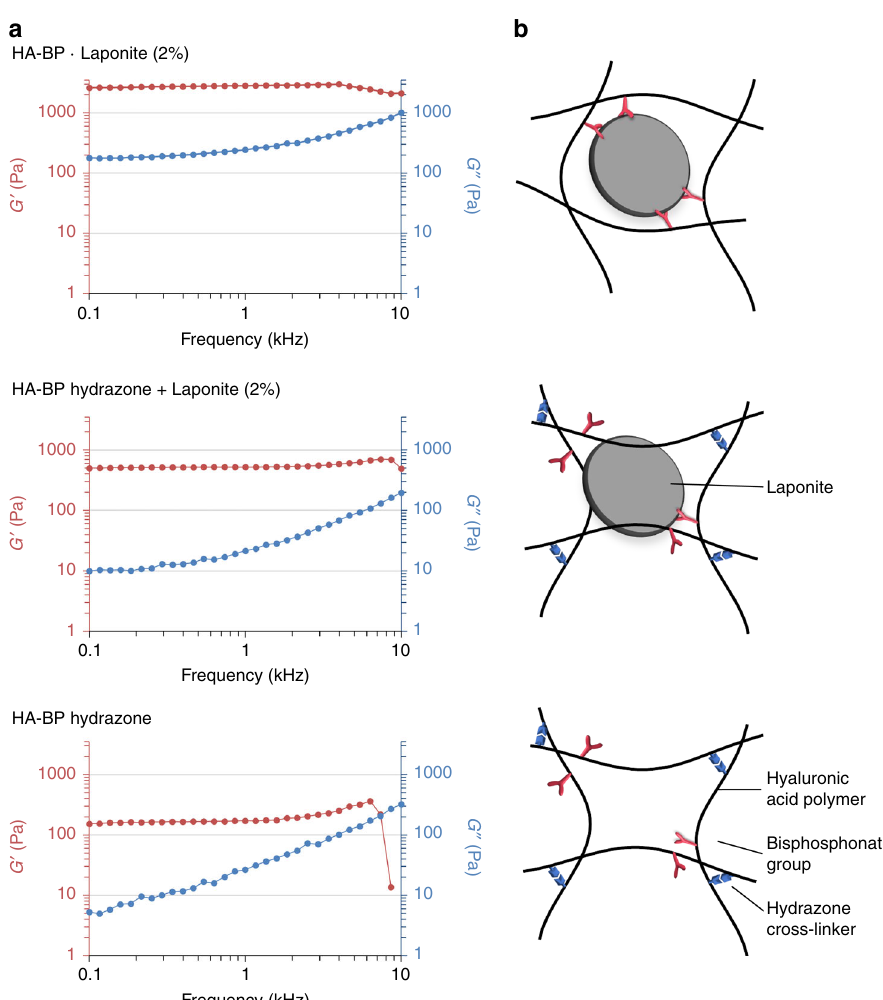
Fig. 2 HA-BP • Laponite gels are stronger than their chemically cross-linked analogs. Frequency sweep measurements of storage and loss modulus of HA-BP • Laponite physical hydrogels and chemically (hydrazone) cross-linked HABP analogs without and with clay ( a ). Schematic of proposed interactions ( b ). Interference of the stronger, but slower forming, BP • Laponite cross-links, by weaker, faster forming hydrazone cross-links could account for the weaker gels formed with addition of Laponite to HABP chemical gels compared to HA-BP • Laponite physical